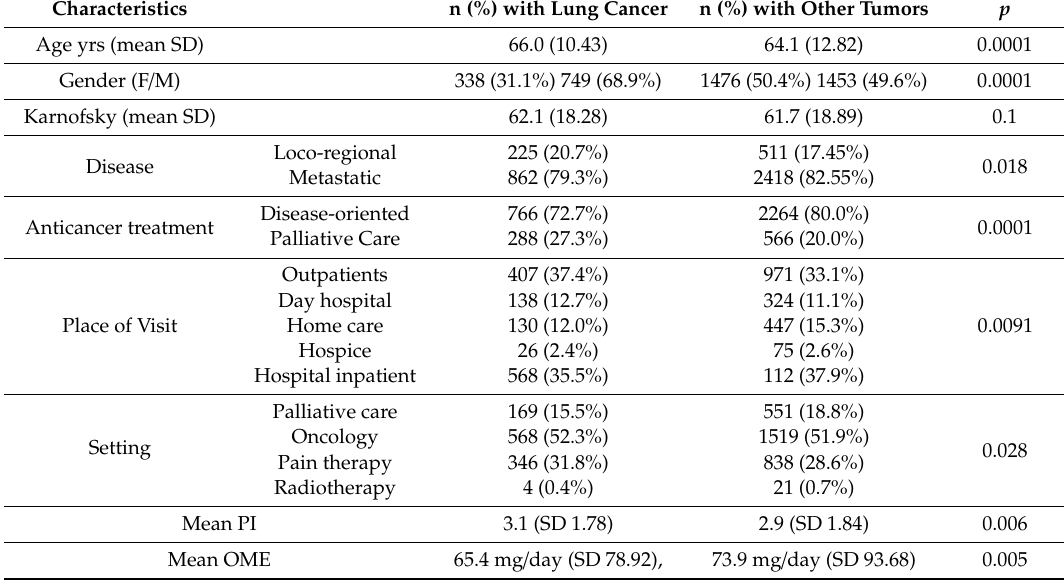
Table 1. Characteristics of patients with lung cancer and other primary